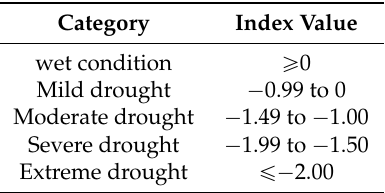
Table 3. Classification of drought according to the SPI, SPEI and SRI